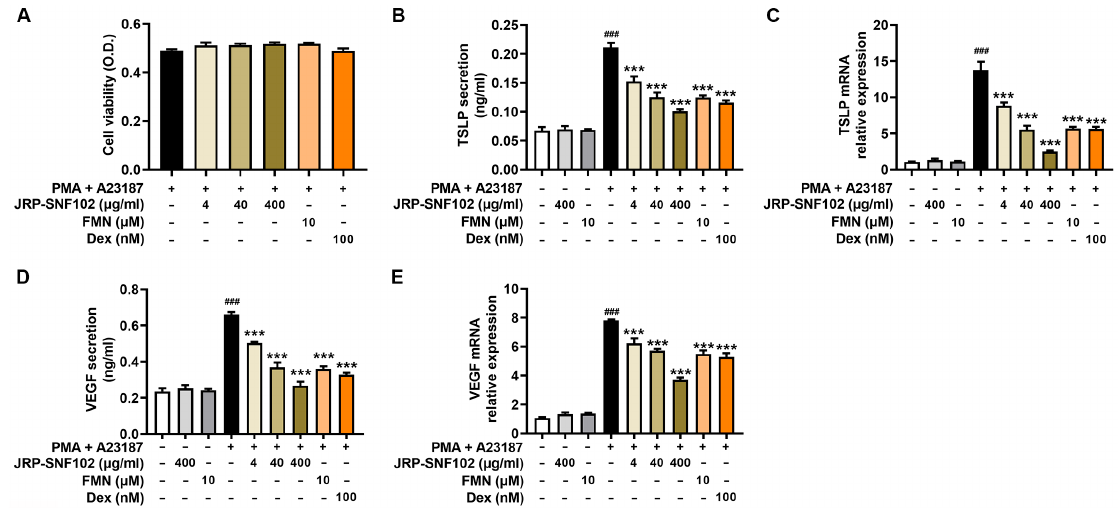
Figure 2. An inhibitory effect of JRP-SNF102 or FMN on TSLP secretion. HMC-1 cells were incubated with or without JRP-SNF102, FMN, or Dex for 1h, followed by PMA and A23187 stimulating for 7 h. ( A ) The cell viability by an MTT assay. ( B , D ) The secretion of TSLP and VEGF by ELISA. ( C , E ) HMC-1 cells were incubated with or without JRP-SNF102, FMN, or Dex for 1h, followed by PMA and A23187 stimulating for 5 h. The mRNA levels of TSLP and VEGF by qPCR. ### p < 0.001 versus normal group; *** p < 0.001 versus PMA and A23187-stimulated group. -, non-treatment; +, treatment.